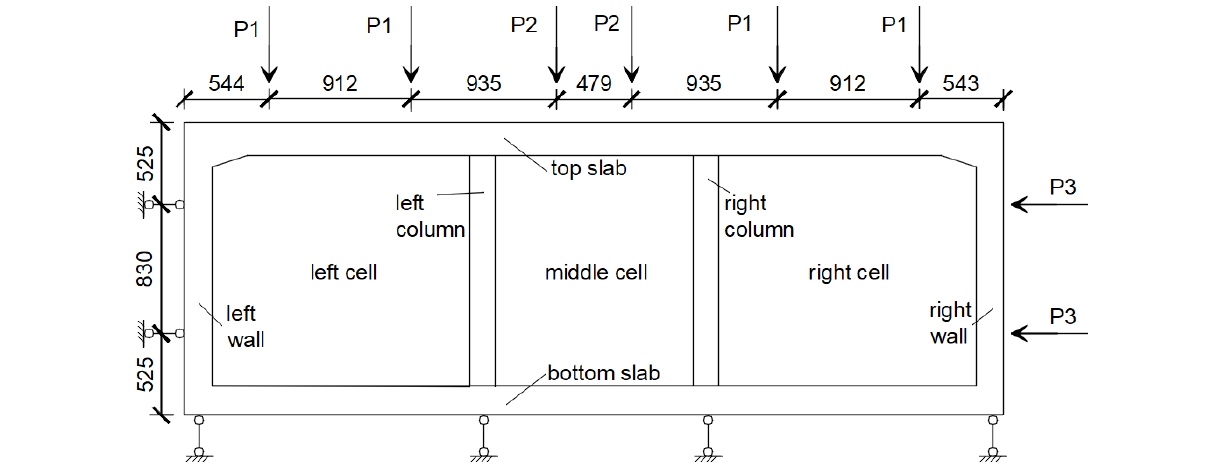
Figure 6. Support and loading conditions of the tested structure, adapted from [40].